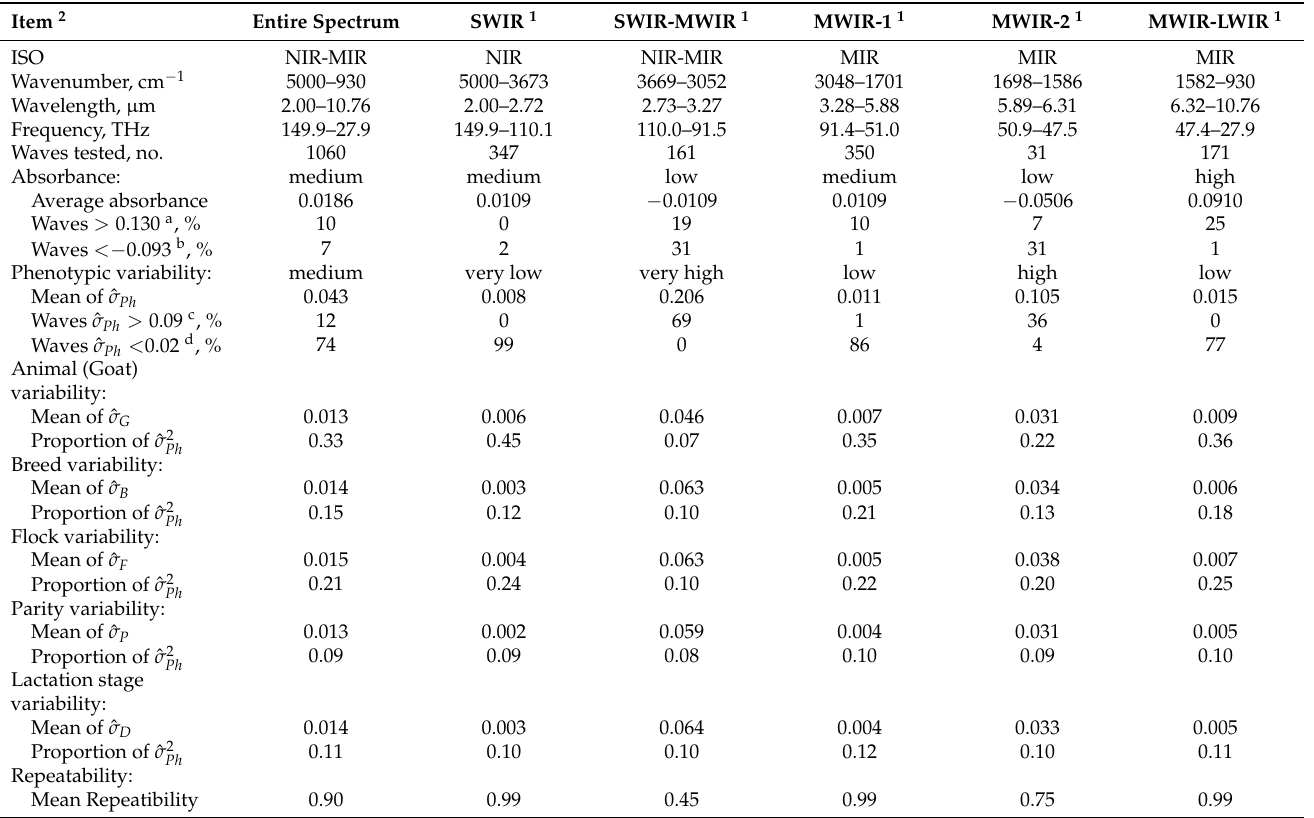
Table 1. Characteristics of the five regions of the FTIR spectrum of goat